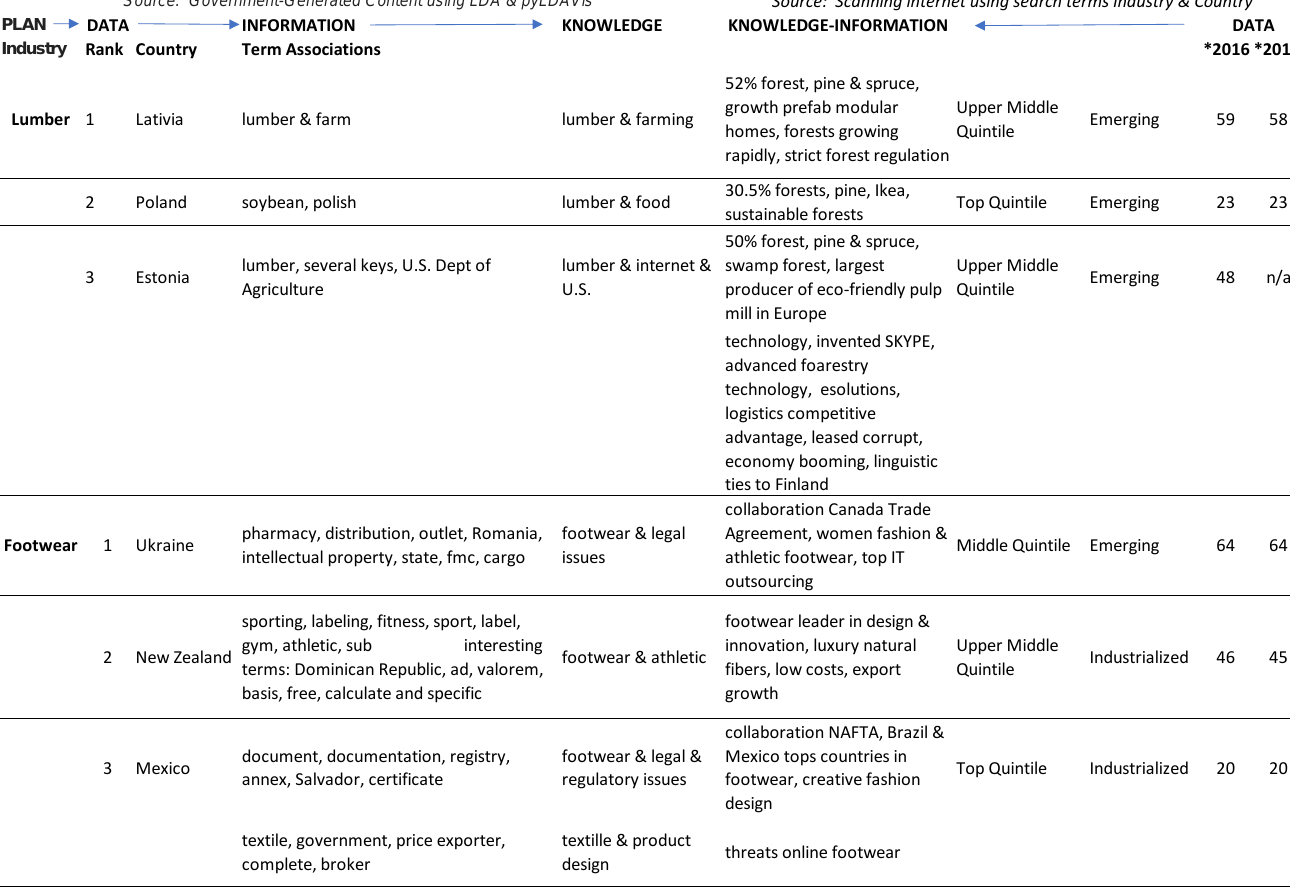
Figure 10. Environmental Scanning for Business Intelligence.